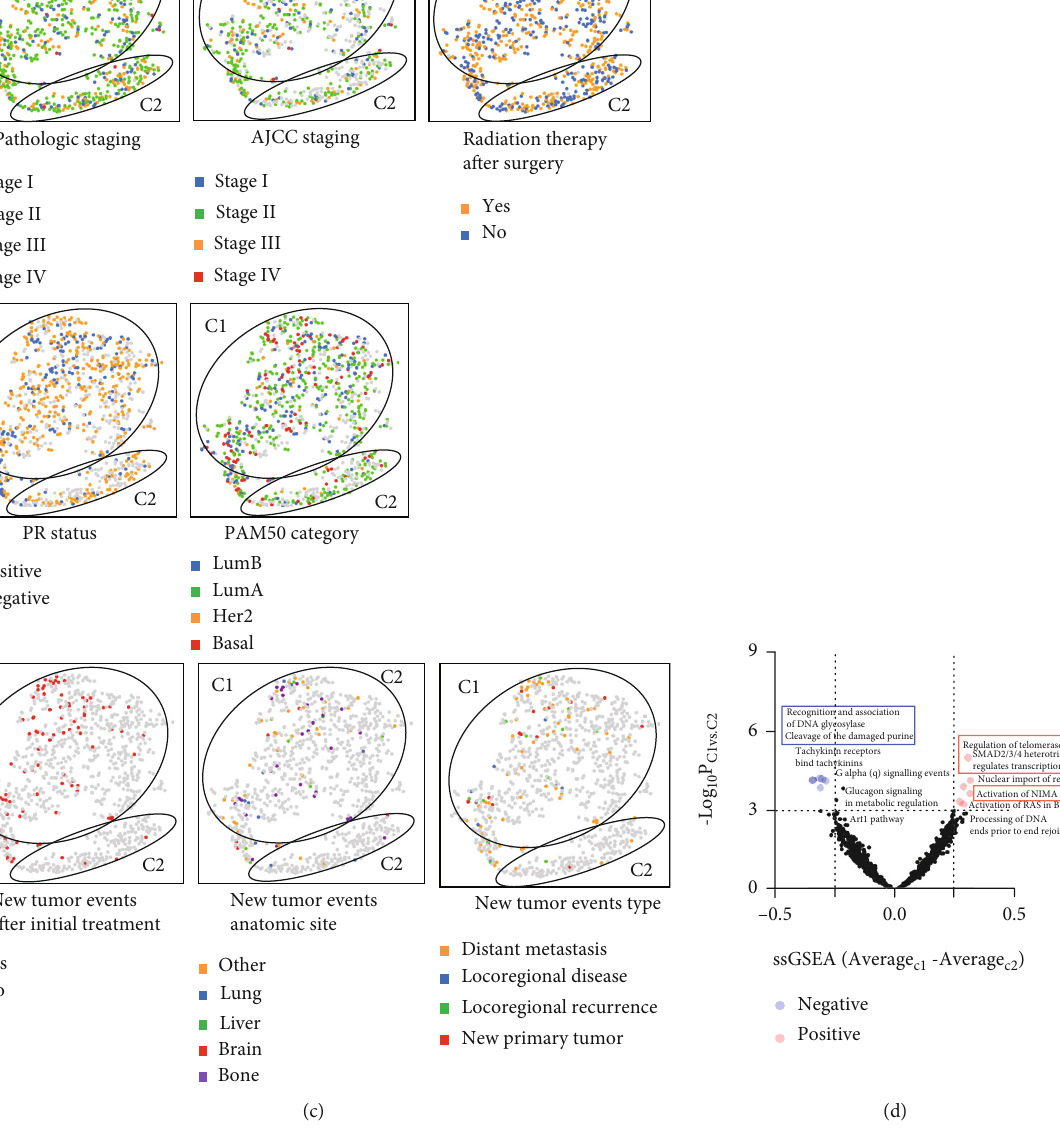
Figure 1: The landscape of ECM-related genes in breast cancer patients. (a) t-SNE method showing the SC3 clustering result. 2 to 4 groups of patients were demonstrated and labeled. (b) Kaplan-Meier analysis comparing the OS, DSS, DFI, and PFI of di ff erent clusters of breast cancer patients in (a). (c) The labeling of pathological stages, AJCC stages, radiation therapy condition, PR status, PAM50 subtypes, postoperative new tumor events, new tumor event anatomic site, and new tumor event types in breast cancer patients. (d) Volcano plot showing the − log ð p Þ and the di ff erence in ssGSEA results in Cluster 1 and Cluster 2 breast cancer patients. Signi fi cant pathways with di ff erence in ssGSEA > 0 : 25 were labeled in red (enhanced in Cluster 1) or blue (suppressed in Cluster